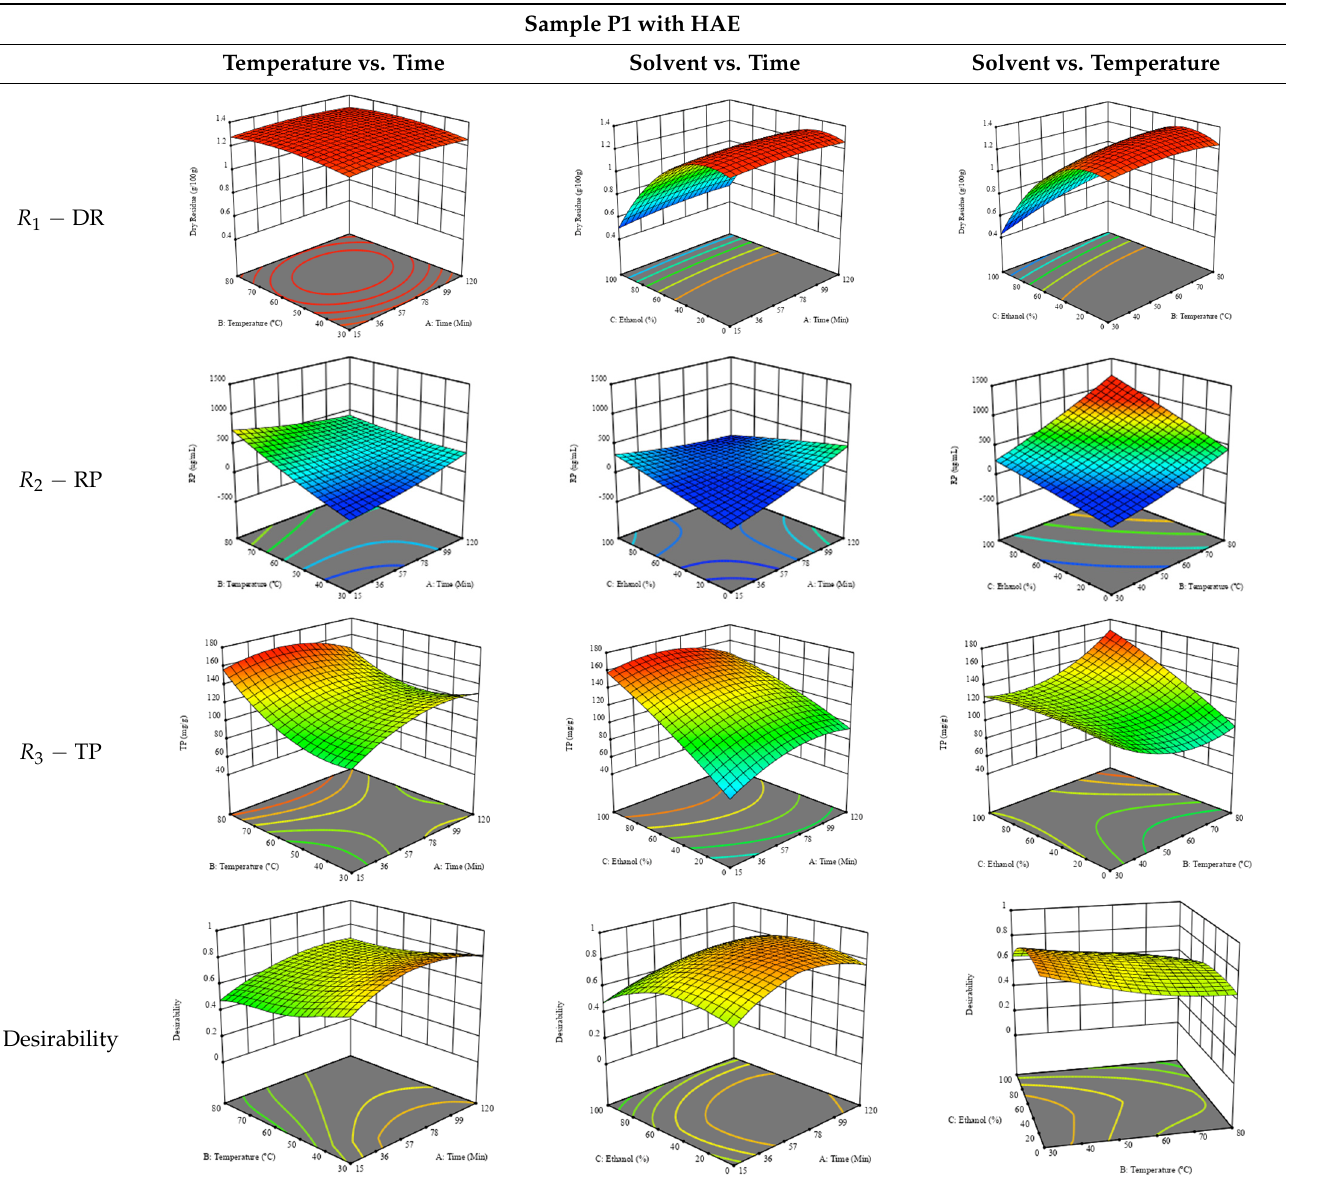
Table 5. 3D response charts of the heat-assisted extraction (HAE) of ‘TL’ peel (P1) at the optimal values. Temperature vs. Time